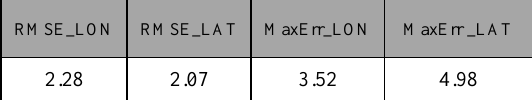
Table 1. Statistics of checkpoint accuracy of reference triangulation (unit: m)